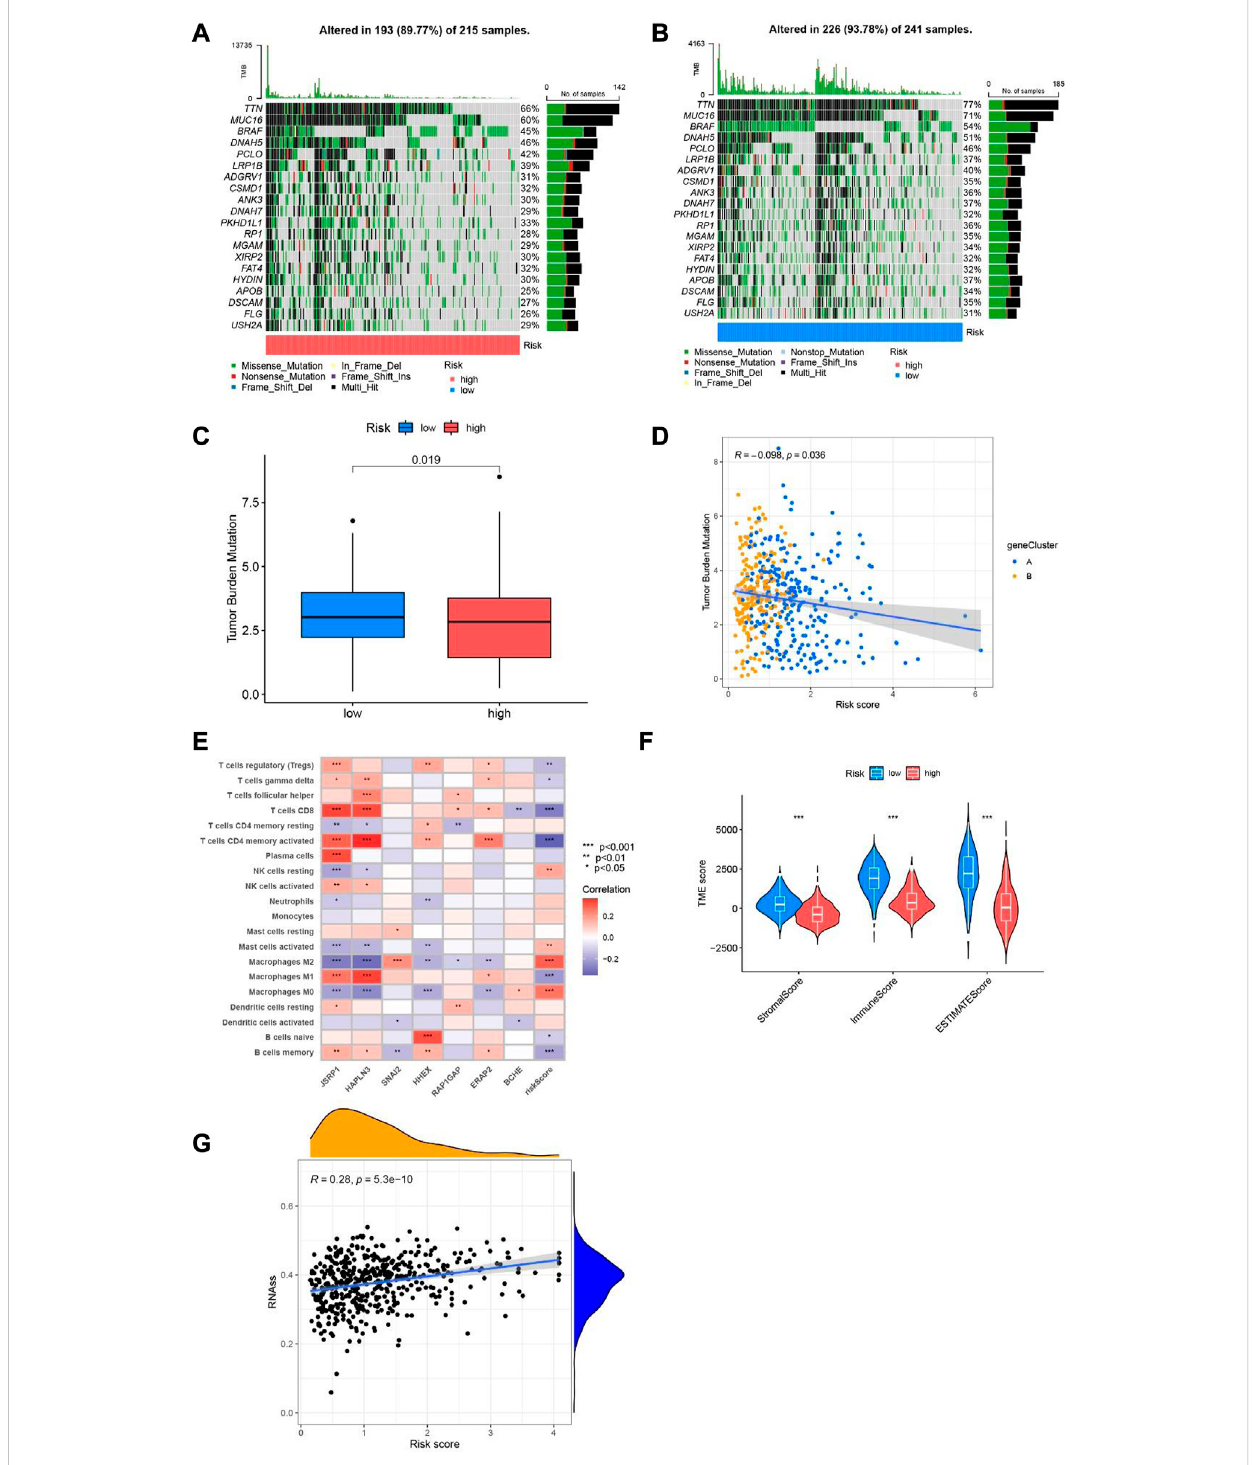
FIGURE 9 Tumormutationload andimmunefunction indifferentriskpopulation. (A) Waterfallplotofmutantgenesinthehigh-riskgroup. (B) Waterfallplotof mutantgenesinthelow-risk group. (C) boxplotdepictthetumormutationalburdenofmelanomapatientsinthetwogroups. (D) Thecorrelationanalysis ofriskscore andtumorburden mutational inmelanoma. (E) Heatmapoftheassociationof7cuproptosis-related differentialgeneswithimmunecells. (F) Violin diagram of StromalScore, ImmuneScore and ESTIMATEScore compared between low-risk group and high-risk group. (G) Relevance analysis between risk score and stemness